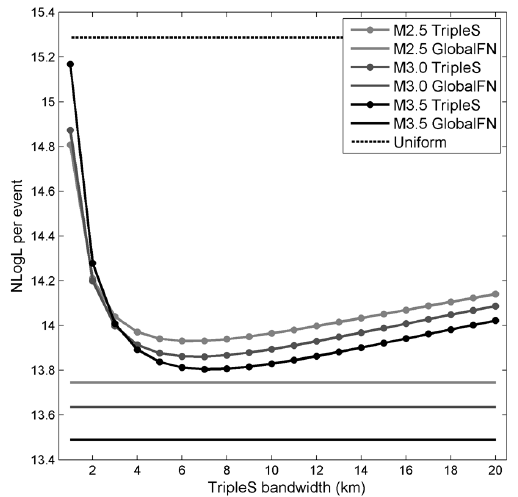
Figure 12. Average negative log likelihood for the target dataset limited to events above M2.5 (light gray), M3.0 (dark gray) and M3.5 (black). Performance of the TripleS models is evaluated as a function of the isotropic kernel bandwidth (dotted lines). The fault network performance is plotted with constant level solid lines. The performance of a single uniformly dense cuboid is plotted with a dashed